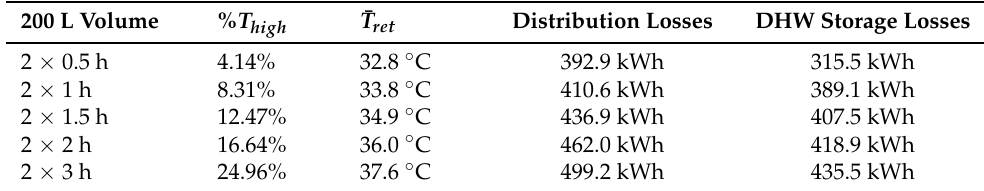
Table 2. Performance of 200 L DHW vessels with increasing CTW. The % T high and ¯ T ret increase when the CTW increases, resulting in higher distribution losses. Moreover, the DHW vessels are recharging more often, which also increases the storage